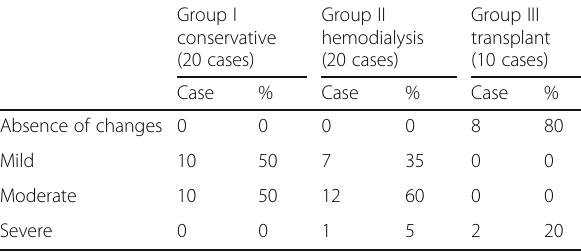
Table 3 Frequency of echocardiography